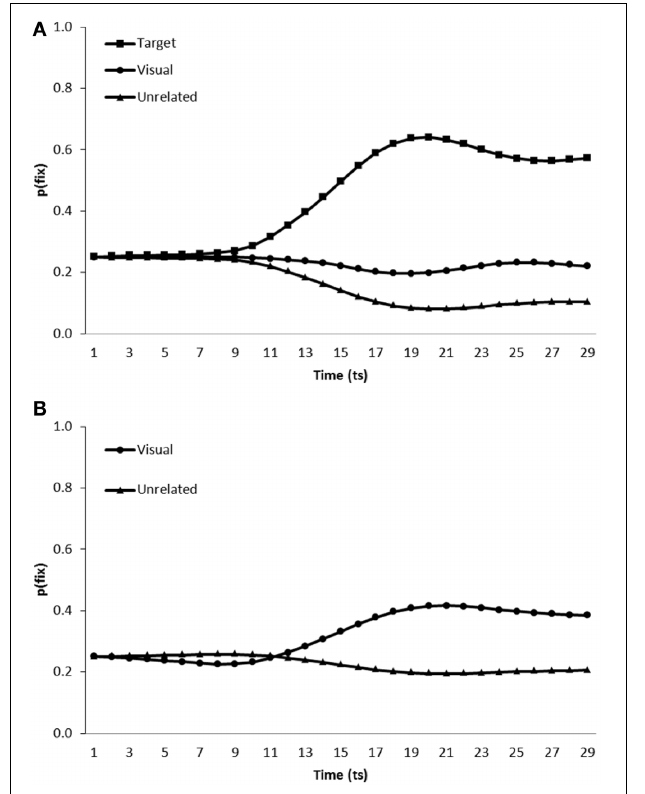
FIGURE 4 | Proportion of fixations [p(fix)] directed toward items within scenes containing (A) a target, a near semantic neighbor (SemNear), a far semantic neighbor (SemFar) and an unrelated distractor, (B) a near semantic neighbor (SemNear), a far semantic neighbor (SemFar) and two unrelated